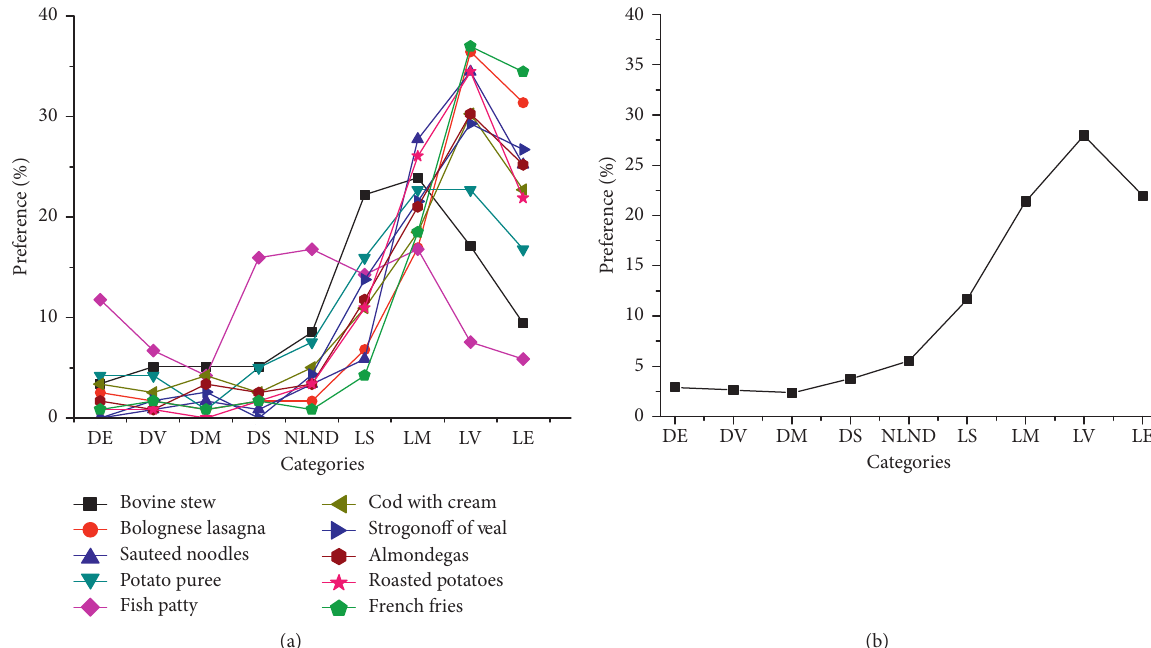
Figure 9: Food preference results. (a) Each ready dishes group food. (b) Ready dishes group as a whole.